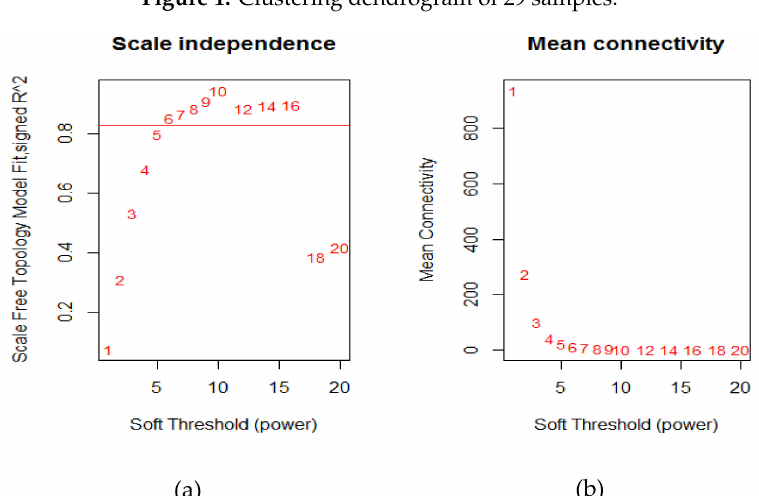
Figure 2. Determination of soft-thresholding power in weighted gene co-expression network analysis (WGCNA) analysis; ( a ) The scale-free fit index for various soft-thresholding powers β ; ( b ) The mean connectivity for various soft-thresholding powers.